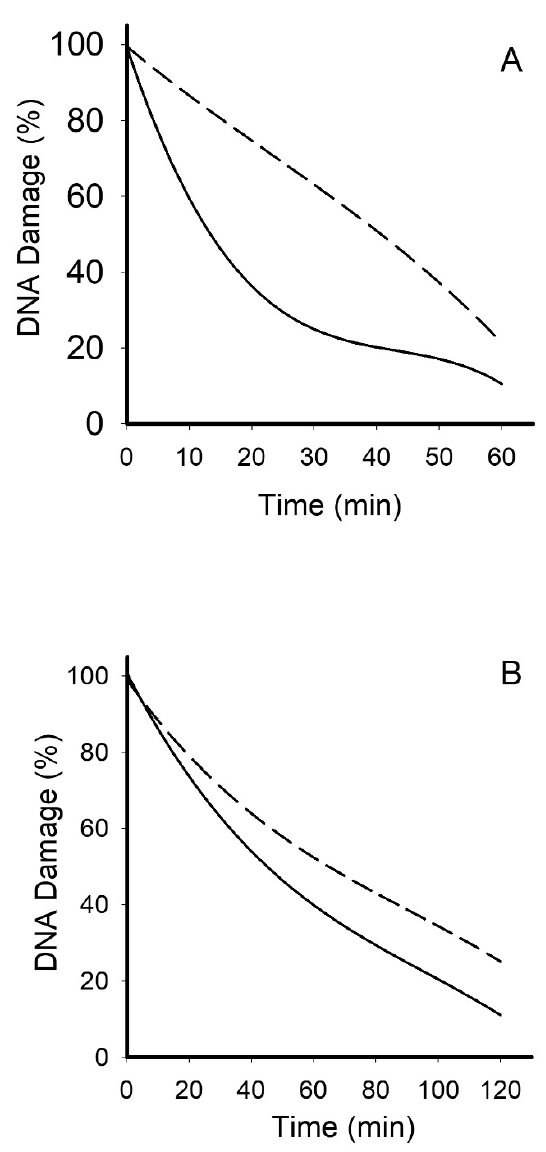
Figure 2. Peripheral blood mononuclear cells (PBMCs) isolated from rheumatoid arthritis (RA) patients have less e ffi cient DNA repair than PBMCs isolated from healthy subjects. Repair of DNA lesions evoked by tert-butyl hydroperoxide ( A ) or bleomycin ( B ) in the PBMCs of 20 healthy control (solid line) and 20 RA patients dashed line). PBMCs were allowed to recover their DNA for 60 min after incubation with tert-butyl hydroperoxide and 120 min after incubation with bleomycin. DNA damage was measured as the percentage of DNA in the tail in the alkaline version of the comet assay. The value of cells scored for each individual was 100. Curves were compared using Receiver Operating Characteristic (ROC) curve.